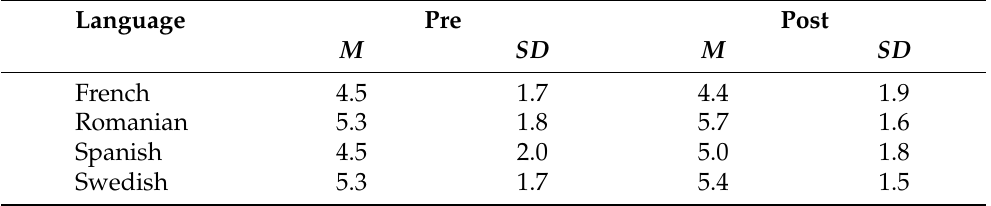
Table A6. I compare different news sources to corroborate the facts.